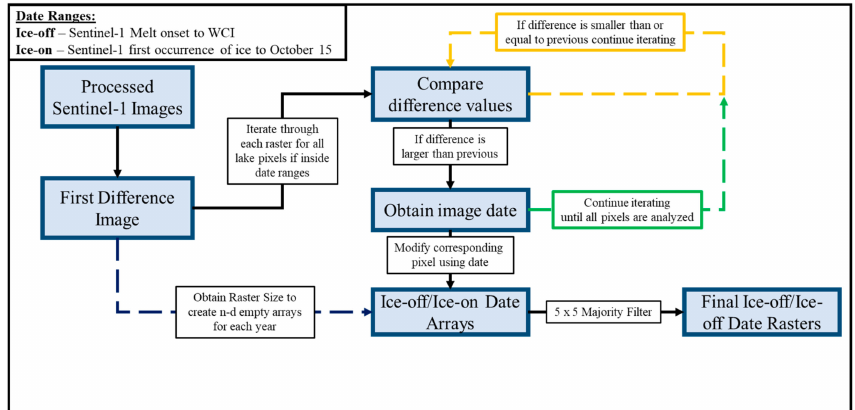
Figure 5. Workflow implemented for determination of lake ice phenology from the backscatter evolution first di ff erence